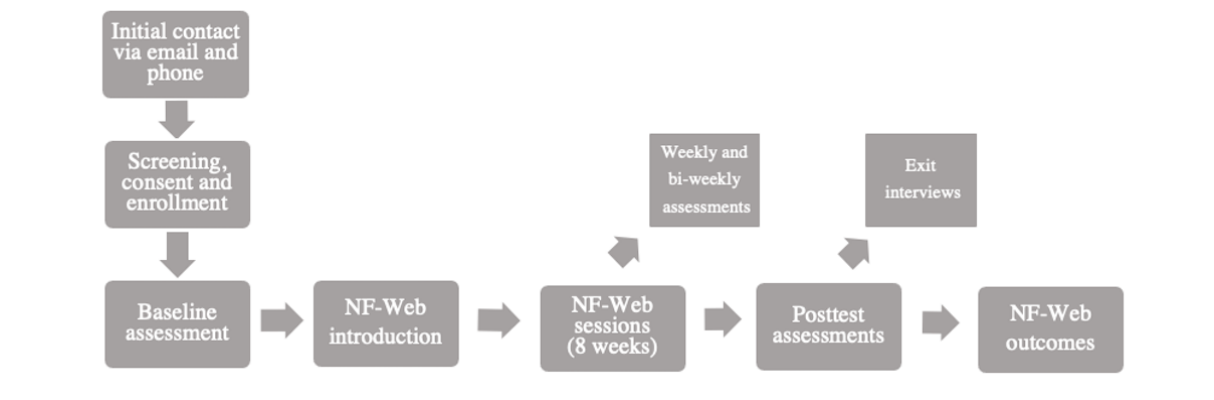
Figure 2. Open pilot study design. NF-Web: